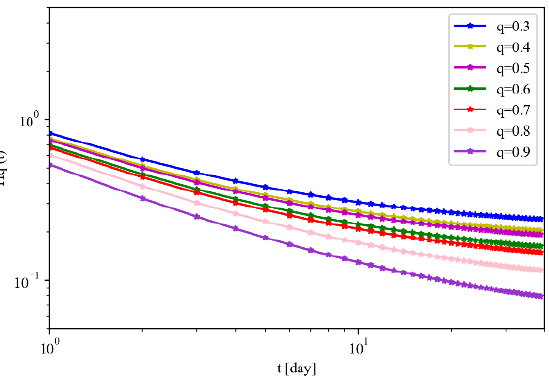
Figure 8. Hazard functions 𝐻 𝑞 of quiet time in different thresholds (Beijing Station).